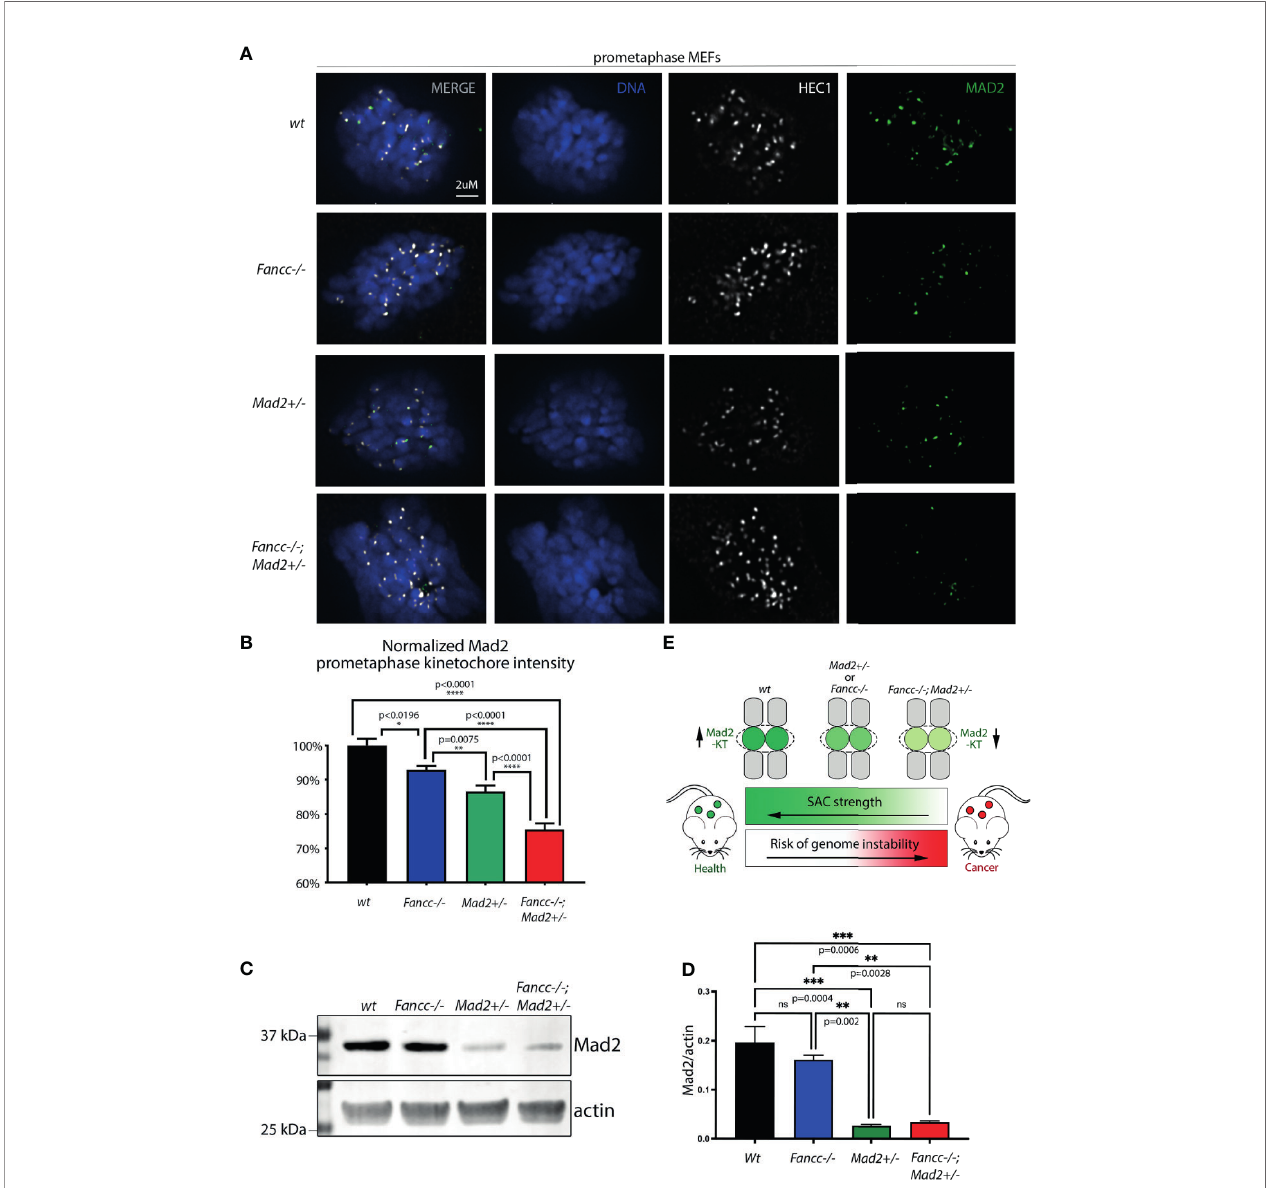
FIGURE 5 | FANCC facilitates SAC function through recruitment of Mad2 to prometaphase KTs. (A) Representative immuno fl uorescent images and (B) quanti fi cation of endogenous MAD2 (green) signal intensity at MEF prometaphase KTs demonstrating decreased KT recruitment of MAD2 upon loss of Fancc (p<0.0196) compared to wt . Endogenous HEC1 (white) is used as a kinetochore marker. Endogenous MAD2 kinetochore immuno fl uorescence intensity was determined by deconvolution microscopy, quanti fi ed via Imaris and compared between genotypes using one-way ANOVA with Bonferroni post-hoc correction. Recruitment of MAD2 to prometaphase KTs is signi fi cantly decreased in Fancc-/-; Mad2+/- cells compared to wt (p<0.0001), Mad2+/- (p<0.0001) and Fancc-/- (p<0.0001) genotypes. (C) Western blotting of MEFs demonstrates that MAD2 expression is not altered upon loss of Fancc [Fancc vs . wt: (p=0.4789). and Mad2+/- vs . Fancc-/-;Mad2+/-: (p=0.9896)], with quanti fi cation of MAD2 signal normalized to actin shown in (D) ("ns" denotes "not signi fi cant"). (E) Summary schematic illustrating that Fancc-/-; Mad2+/- mice have decreased targeting of MAD2 to KTs, resulting in impaired SAC function and heightened genomic instability. *p < 0.05, **p < 0.01, ***p < 0.001, ****p <